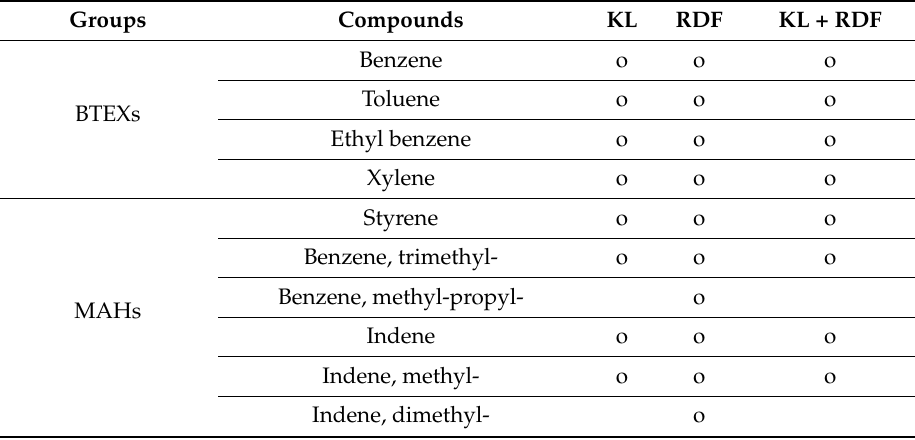
Table 3. List of detailed compounds of CP and